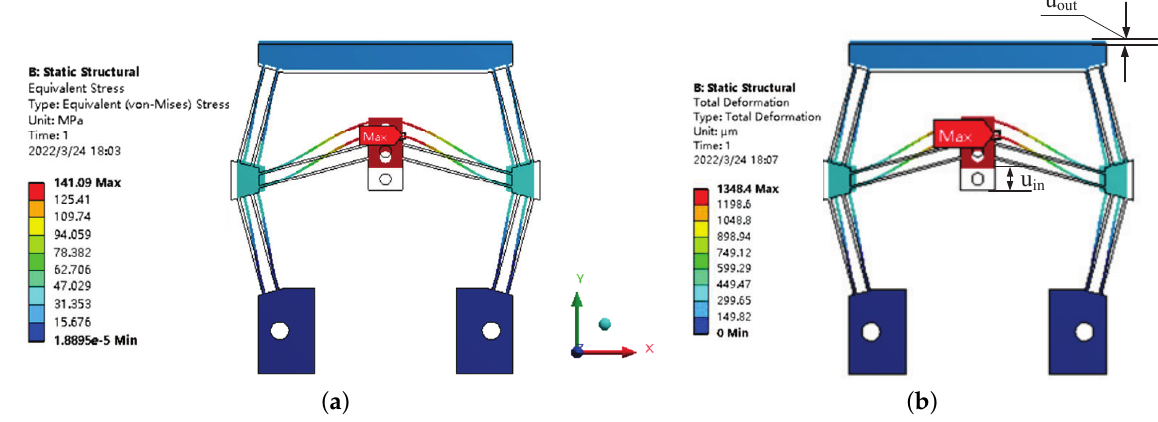
Figure 5. Static deformation and von Mises stress analyzed by FEA. ( a ) von Mises stress. ( b ) Static